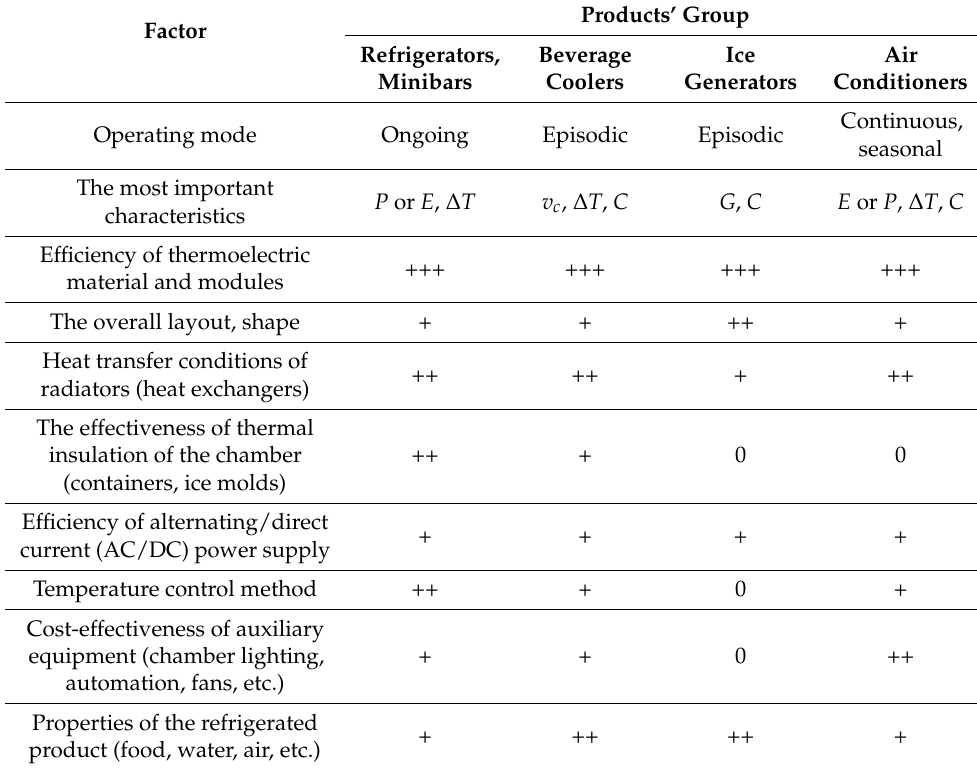
Table 5. Qualitative analysis of the degree of influence of the selected design and operational factors on the most important technical characteristics of household thermoelectric devices. Products’ Group Factor Refrigerators, Beverage Ice Air Minibars Coolers Generators Conditioners Continuous, Operating mode Ongoing Episodic Episodic seasonal The most important P or E , ∆ T v c , ∆ T , C G , C E or P , ∆ T , C characteristics Efficiency of thermoelectric +++ +++ +++ +++ material and modules The overall layout, shape + + ++